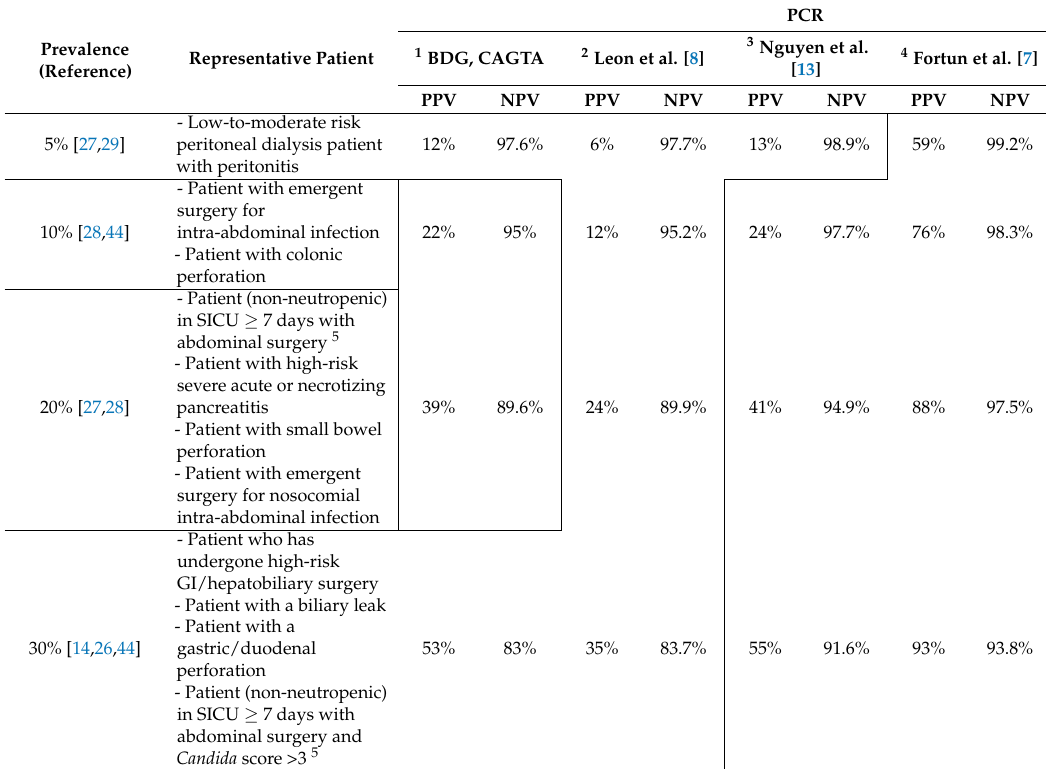
Table 2. Prevalence of intra-abdominal candidiasis in different populations, and anticipated PPVs and NPVs of non-culture